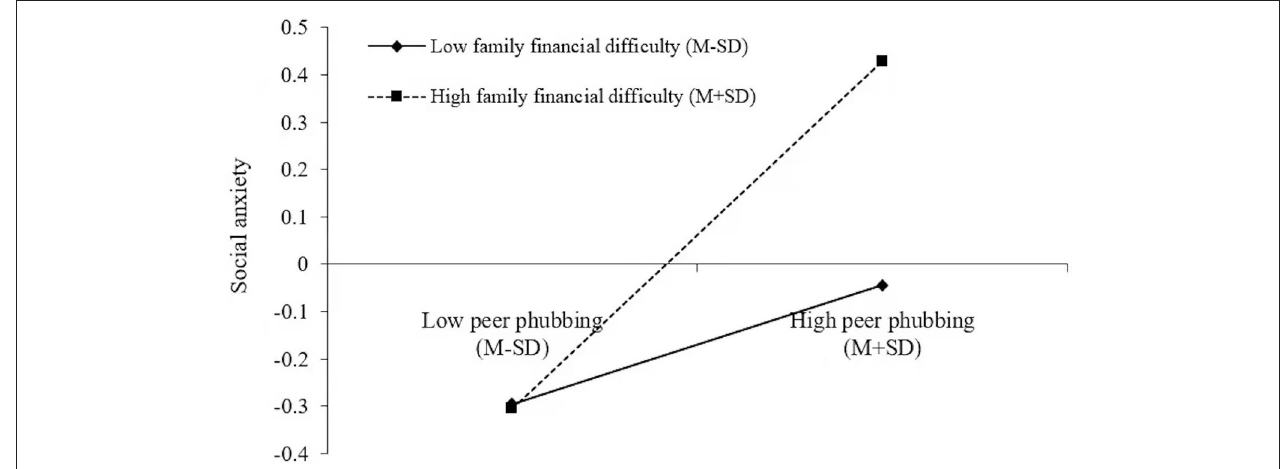
FIGURE 2 | Family financial difficulty moderates the relationship between peer phubbing and social